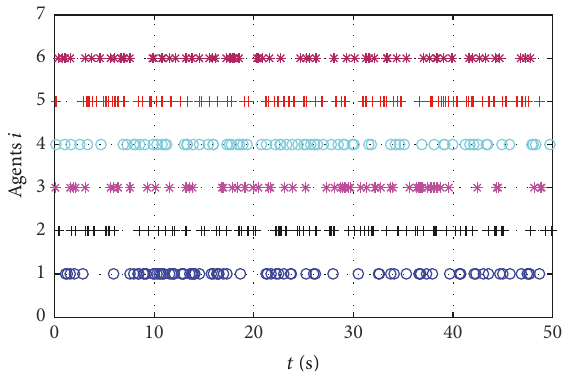
Figure 9: Events times of all agents in Case 1.